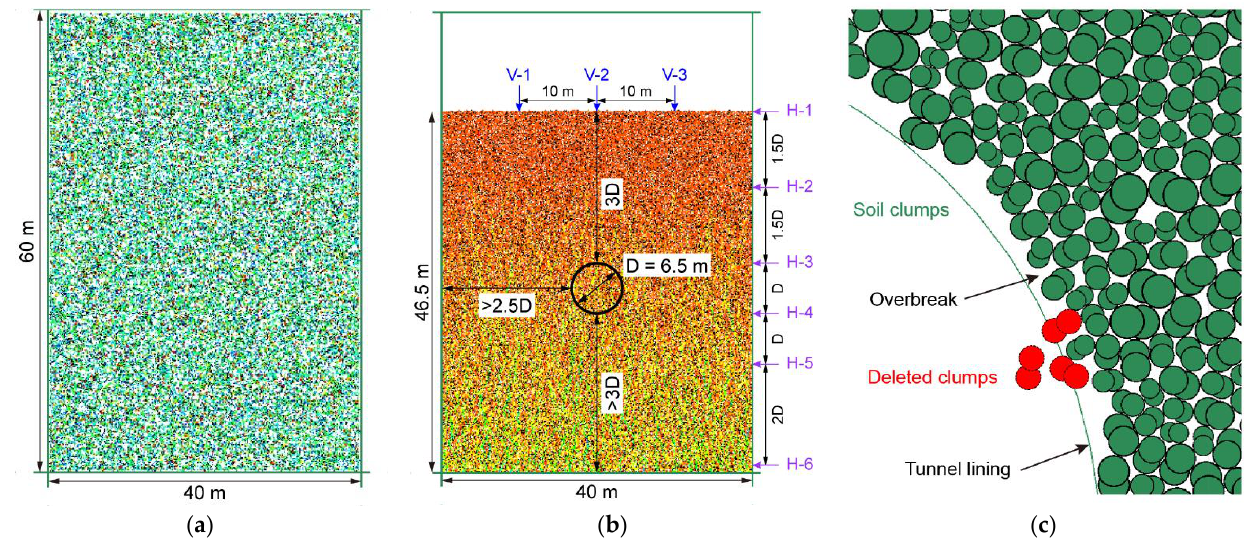
Figure 7. Configuration of the circular tunnel excavation: ( a ) initial model before consolidation; ( b ) consolidated model and the location of the tunnel; ( c ) tunnel lining model.